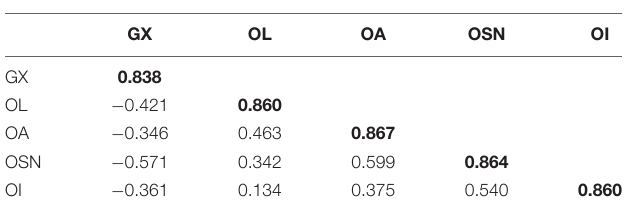
TABLE 4 | Discriminant